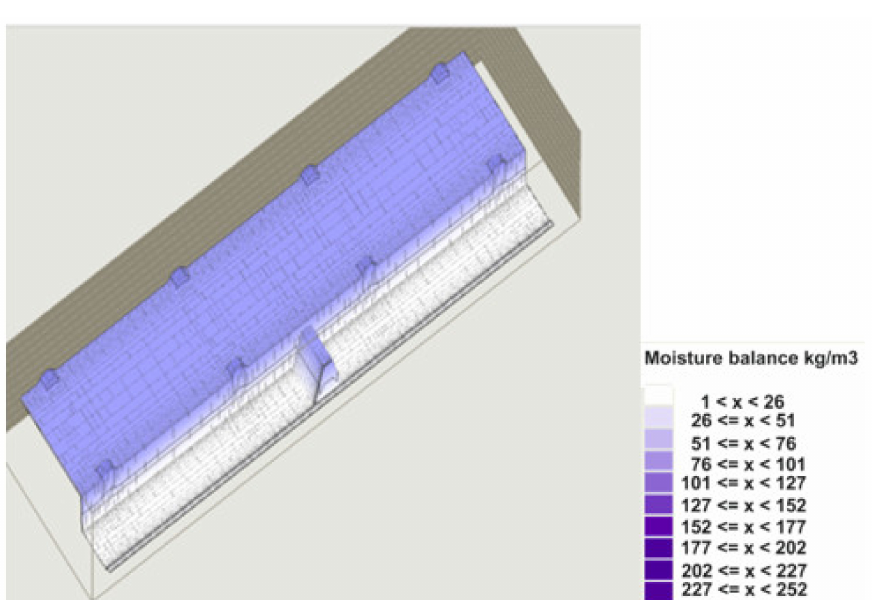
Figure 27. Wall insulated with light aerated concrete—initiation time (0